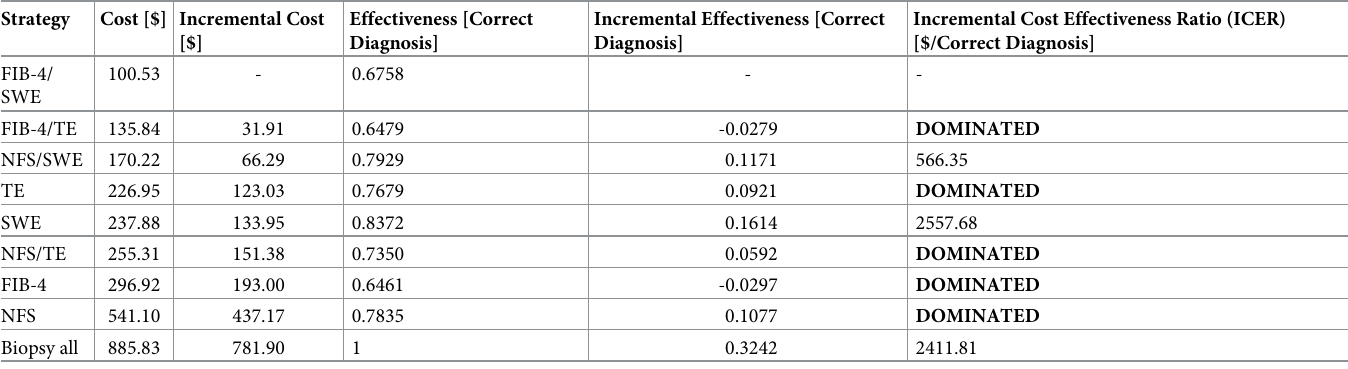
Table 3. Cost-effectiveness of finding F2 fibrosis in all patients. Strategy